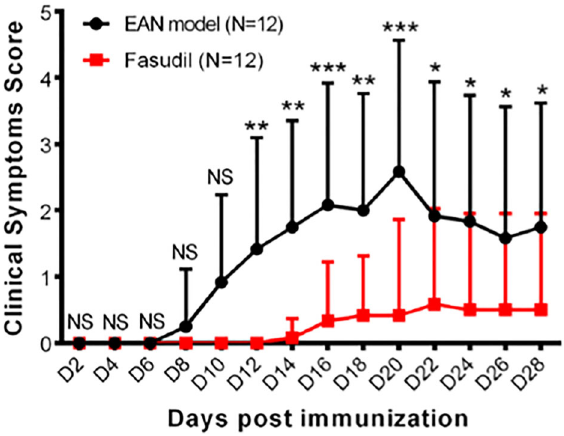
Figure 1. Clinical symptoms score at each assessment after induction of experimental autoimmune neuritis (EAN) in mice treated with fasudil and control (EAN model). Data are reported as mean and SD. *P o 0.05, **P o 0.01, ***P o 0.001 compared to the EAN model ( t -test). NS, not signi fi